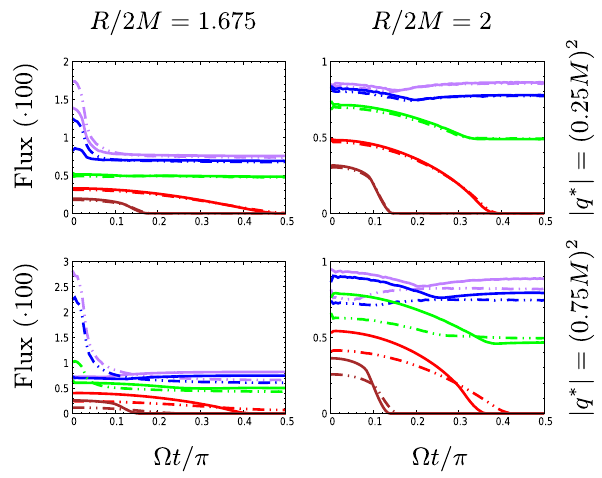
Fig. 26 Pulse profile for single caps. Exponential decay, ξ = χ = π/ 2. The purple, blue, green, green, red, and brown lines correspond to (cid:11) = 0 . 00, 0 . 30, 0 . 60, 0 . 90 and 0 . 99 respectively. The solid lines correspond to q ∗ > 0 while the dashed lines correspond to q ∗ < 0